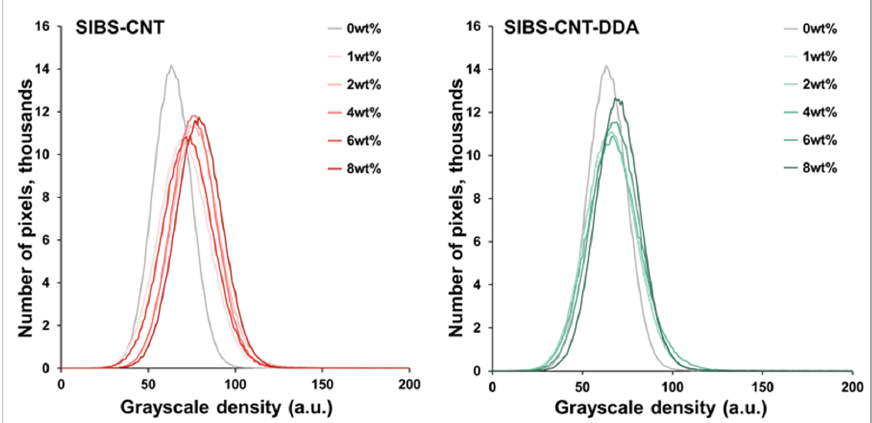
Figure 5. Influence of CNT and CNT-DDA concentration on X-ray density of SIBS films.